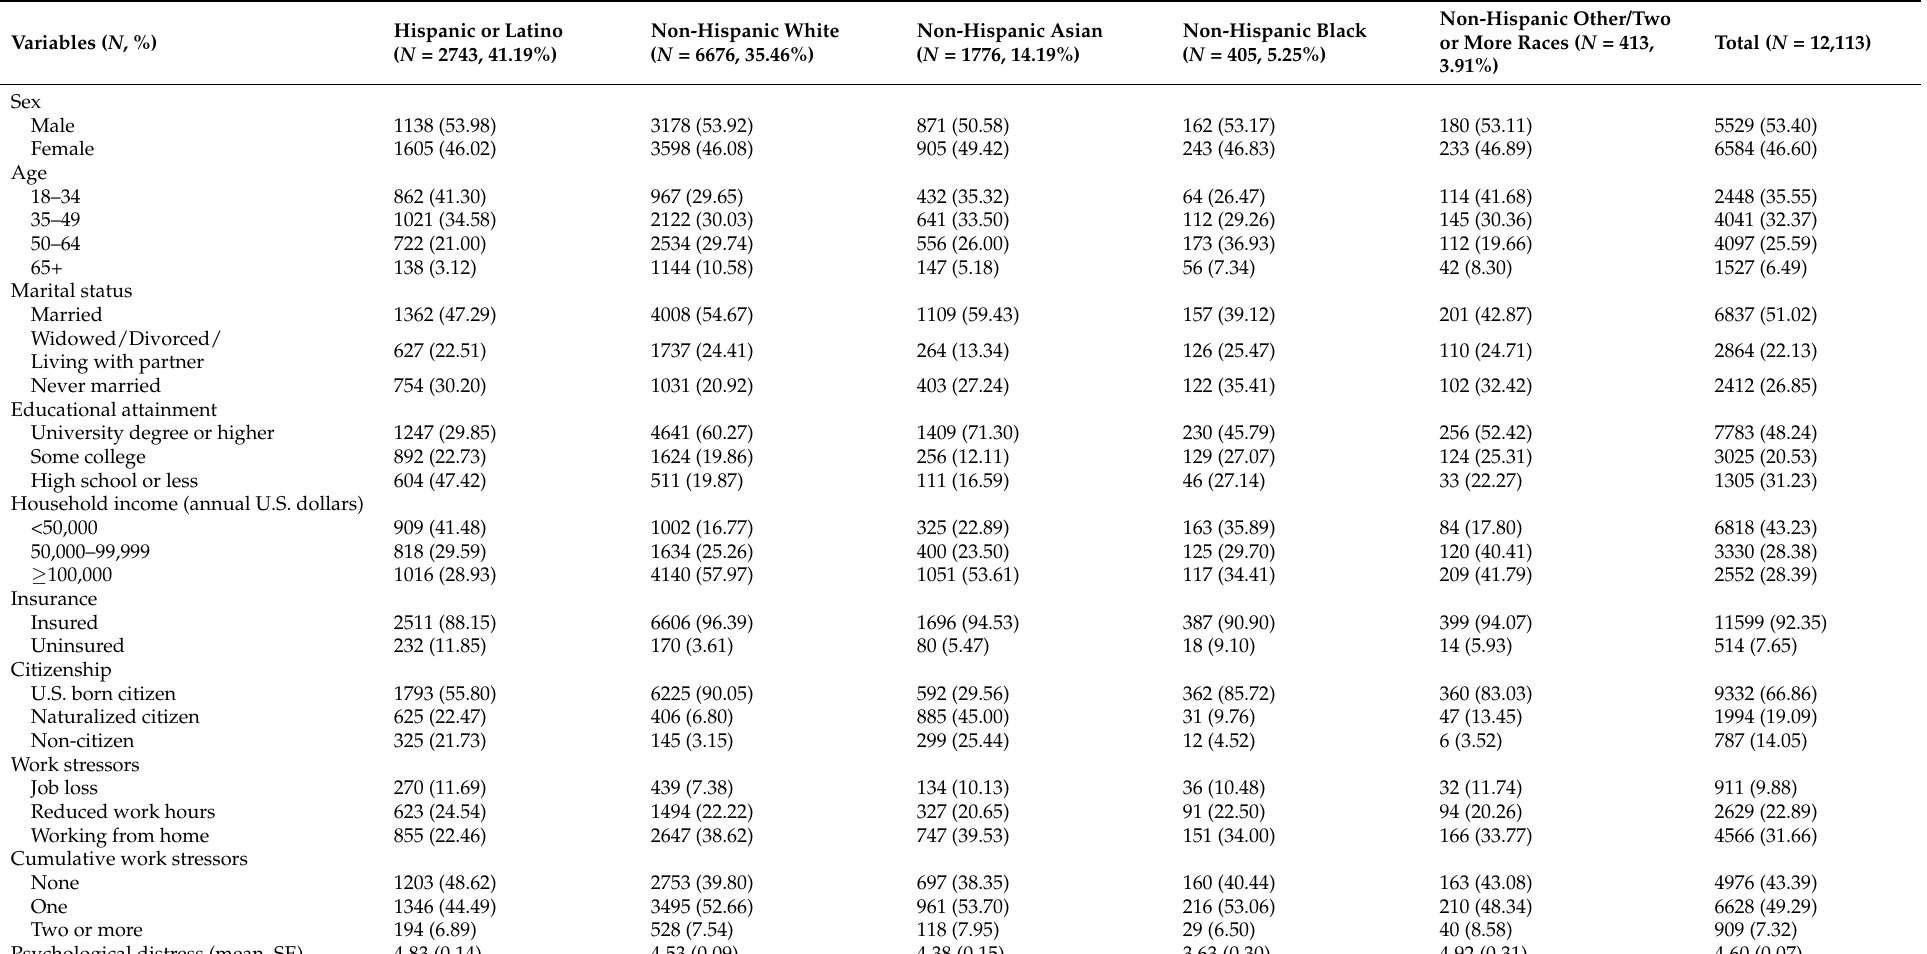
Table 1. Characteristics of the Sample Population in CHIS 2020, Weighted ( N =